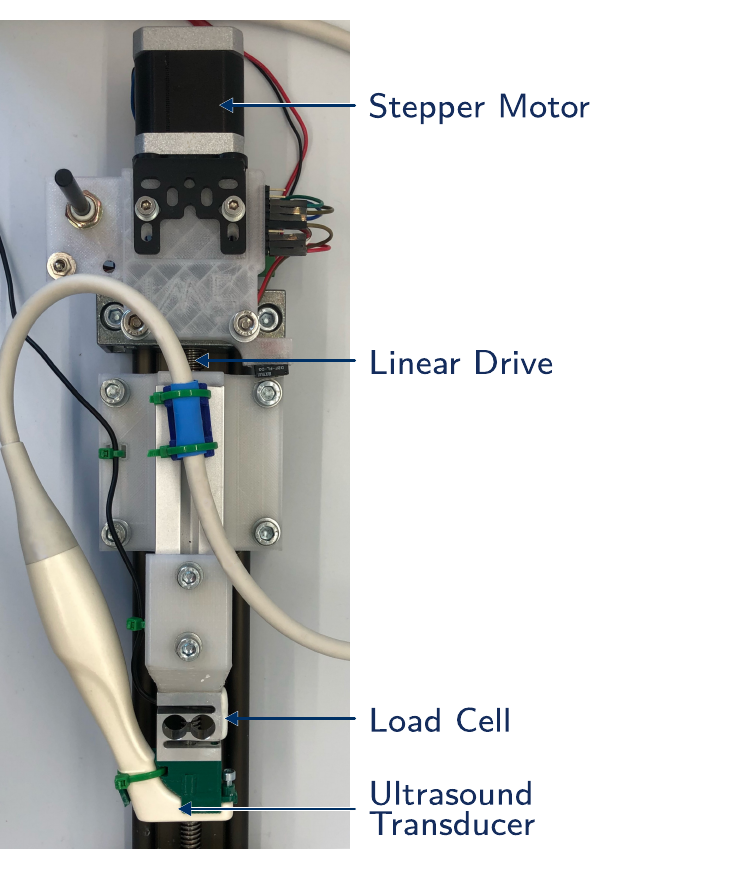
Figure 1. The experimental setup: the stepper motor is used to power the linear drive, which compresses the specimen with the ultrasound transducer. The compressing force is measured by the load